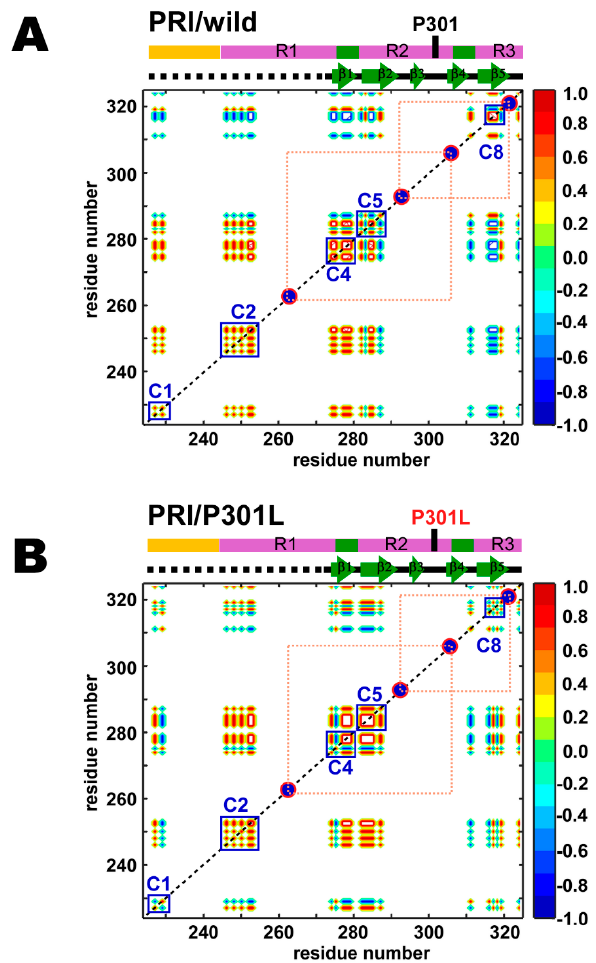
Figure 5. PRI correlation maps for the ( A ) wild-type and ( B ) P301L mutant of TauF4 ∆ . Only residues with observable PRI rates for two variants are shown. The red circles filled in dark blue indicate the positions of the MTSL labels. The MTSL positions connected by orange dotted lines are used for the simultaneous spin-labeling. Segments comprising residues with local correlations are marked by the blue squares labeled by the closely corresponding segments in the PRE map. Colors of the contours indicate the degrees of correlations as used in the PRE maps: correlated (red), anti-correlated (blue) and uncorrelated (green).